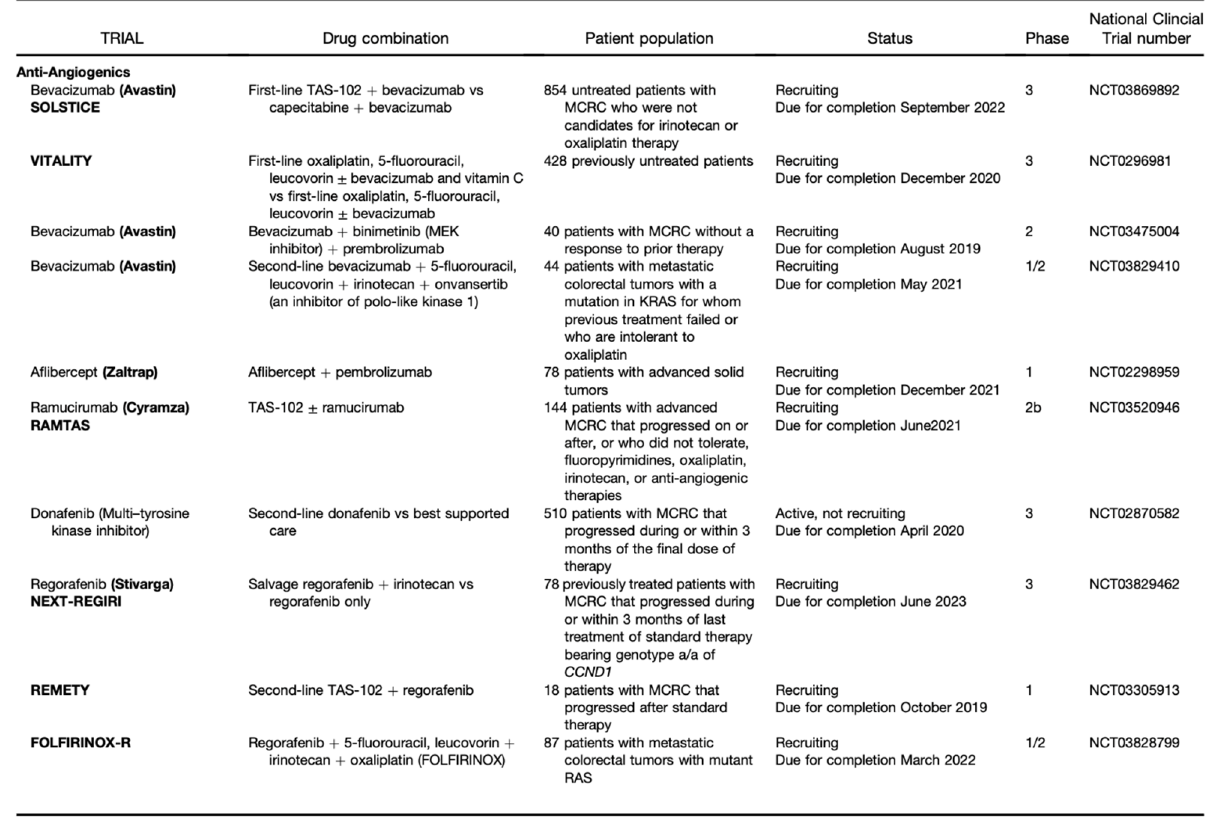
Figure 2. Part I: Clinical Trials of Agents Designed to Target Tumor Stroma. From Fridman et al [9].